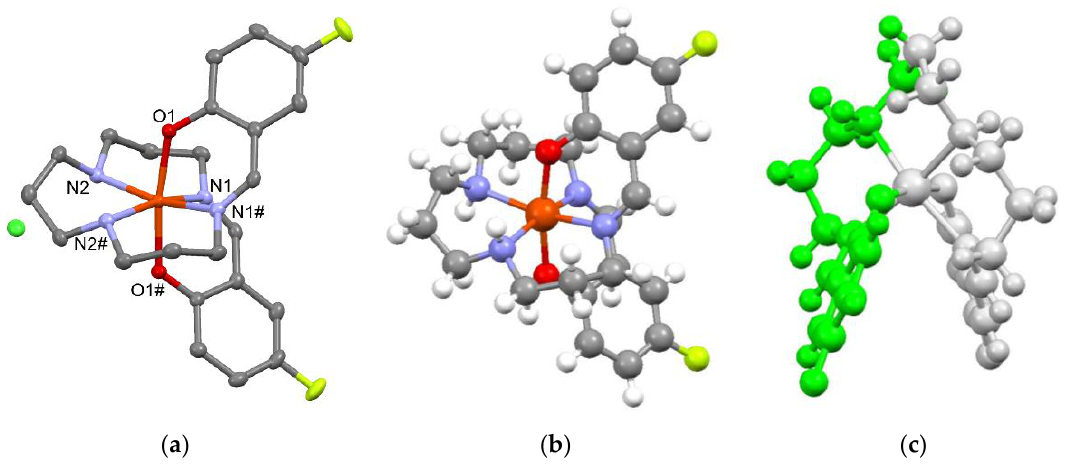
Figure 3. ( a ) View of [Fe(5F-sal 2 333)]Cl, complex 1 , showing symmetry equivalence of donor atoms related by the central C2 axis, ( b ) view of the complex cation showing the orientation of hydrogen atoms, including the non- meso arrangement of amine hydrogens, and ( c ) depiction of the symmetry relationship of the two halves of the complex.